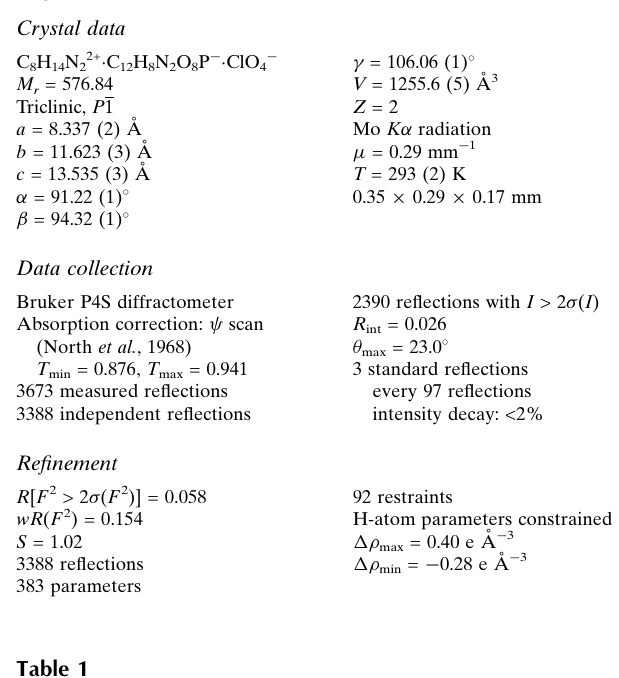
Hydrogen-bond geometry (A˚ , (cid:3)